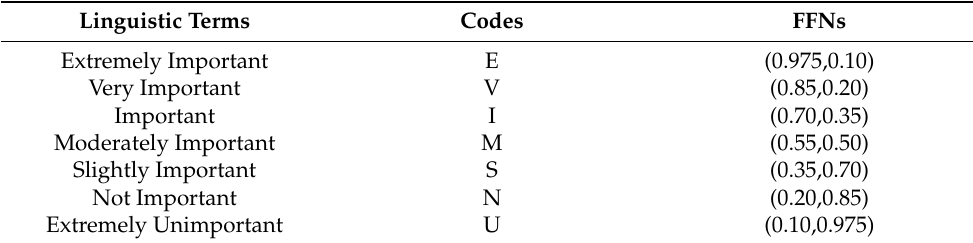
Table 5. Linguistic terms for assessing